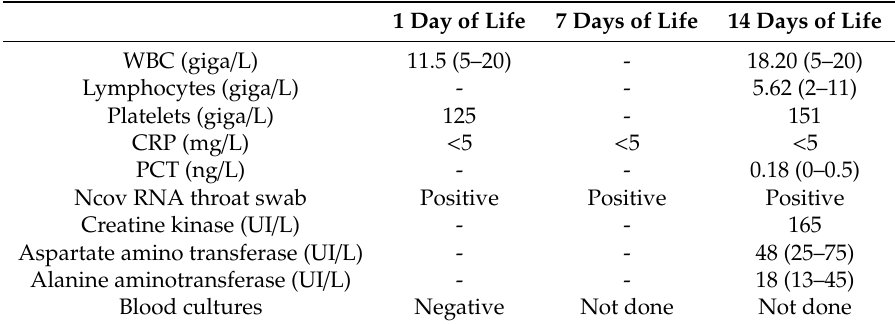
Table 1. Laboratory test results of the